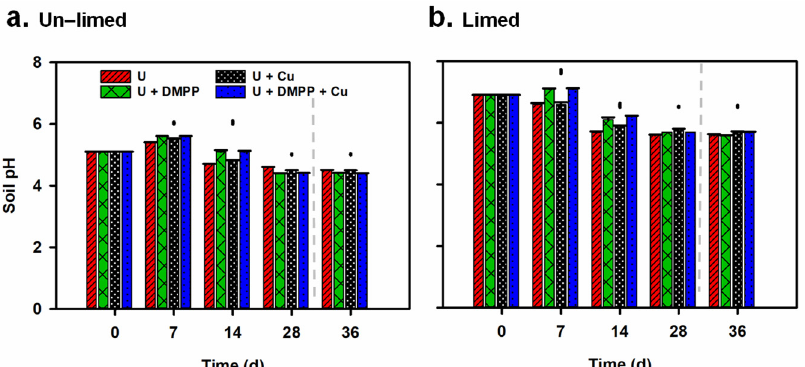
Figure 1. Changes in soil pH after application of urea, DMPP, and Cu in the ( a ) un-limed soil and ( b ) limed soil. The soil water was maintained at 55% WHC for the first 28 d then increased to 90% WHC for the remainder of the experimental period (as indicated by the grey broken vertical line). Data are the means of four replicates ±SE. The single vertical bars indicate the least significant differences among treatments (LSD 0.05 ).